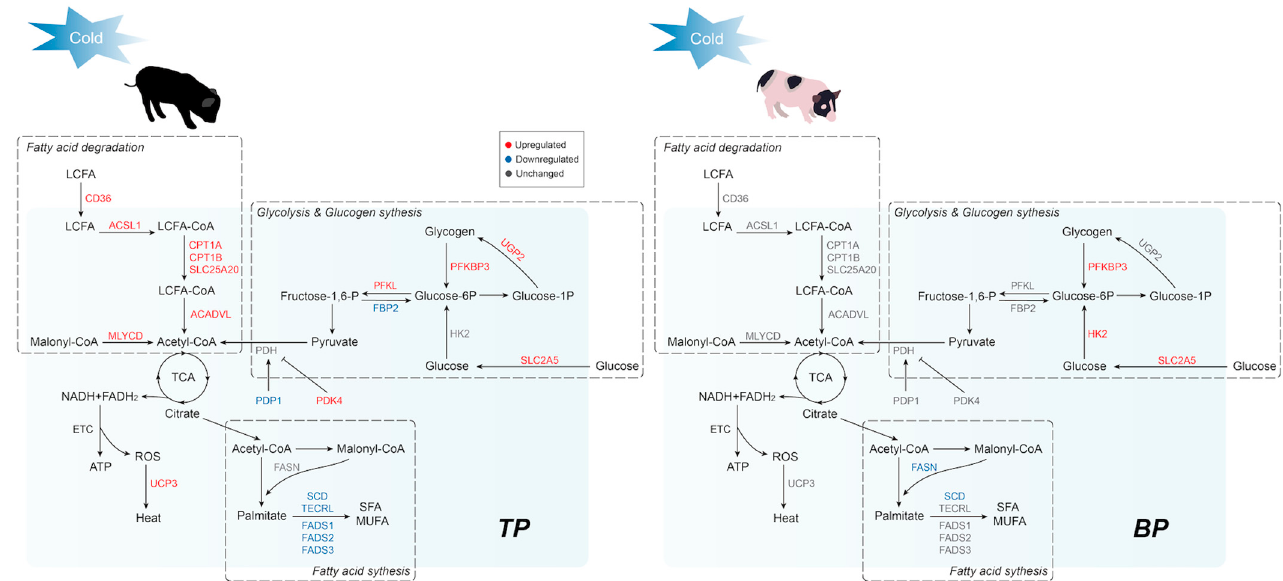
Figure 6. Schematic diagram of the distinct transcriptomic responses to short-term cold exposure in the BF of Tibetan and Bama pigs; pathways and genes involved in fatty acid, glucose, and glycogen metabolism are shown in the diagram.